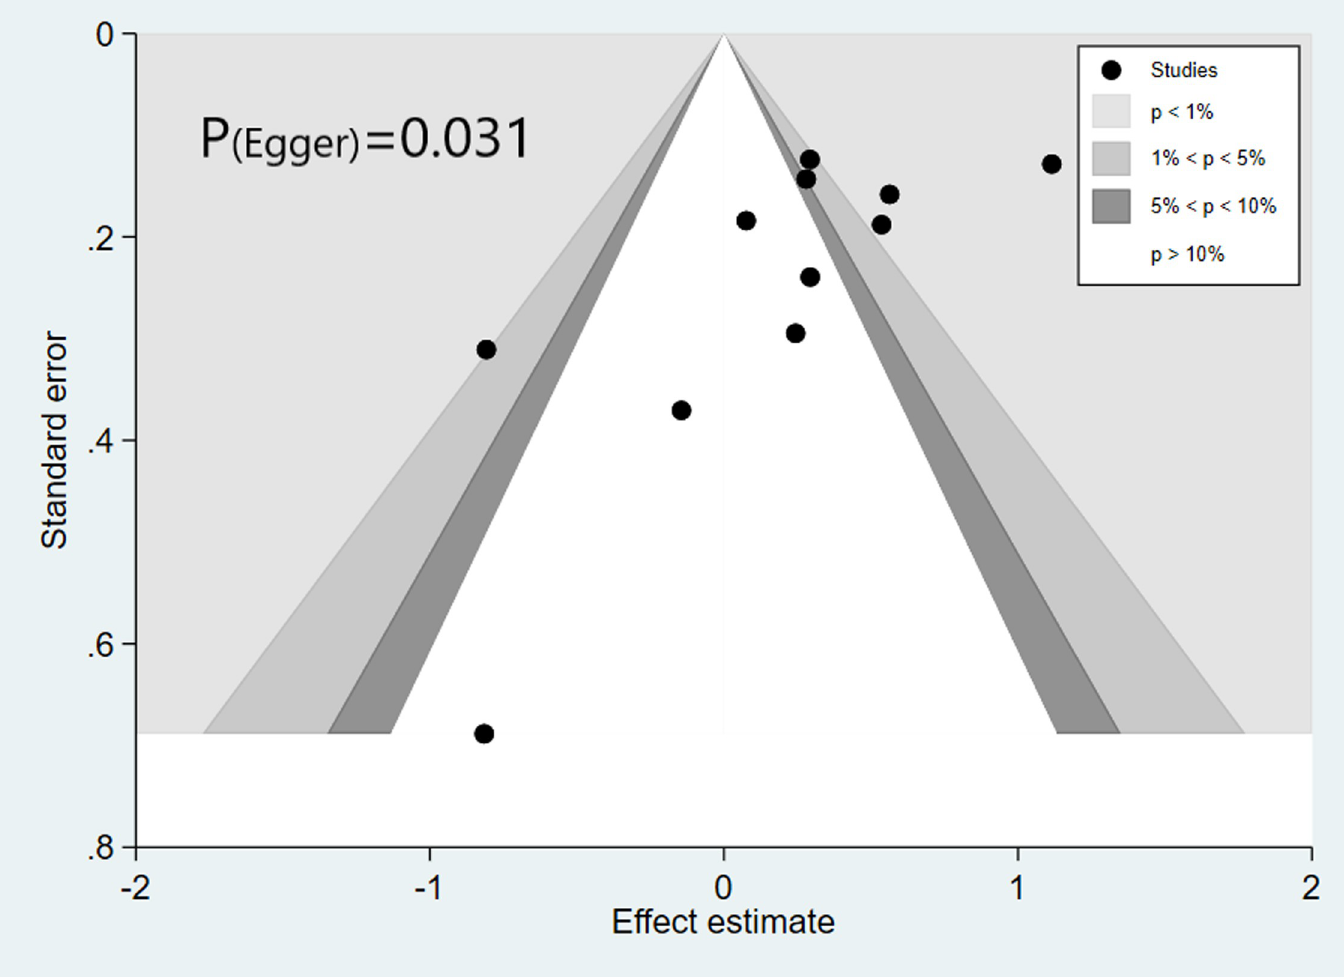
Fig 3. Funnel plot with Egger’s test for d-dimer levels and severity. Unadjusted effect estimates from individual studies were plotted against their standard error. Solid and dashed lines represent the summary effect estimate and its 95% confidence intervals for different values of the standard error, respectively. Egger’s test estimated bias: p = 0.031. (A) Funnel plot assessing publication bias in RCTs investigating the effectiveness of different types of respiratory PPE against clinical (influenza-like illness and clinical respiratory illness) or laboratory-confirmed outcomes (influenza or other viral or bacterial respiratory infections); Harbord’s estimated bias coefficient: -0.59; p =